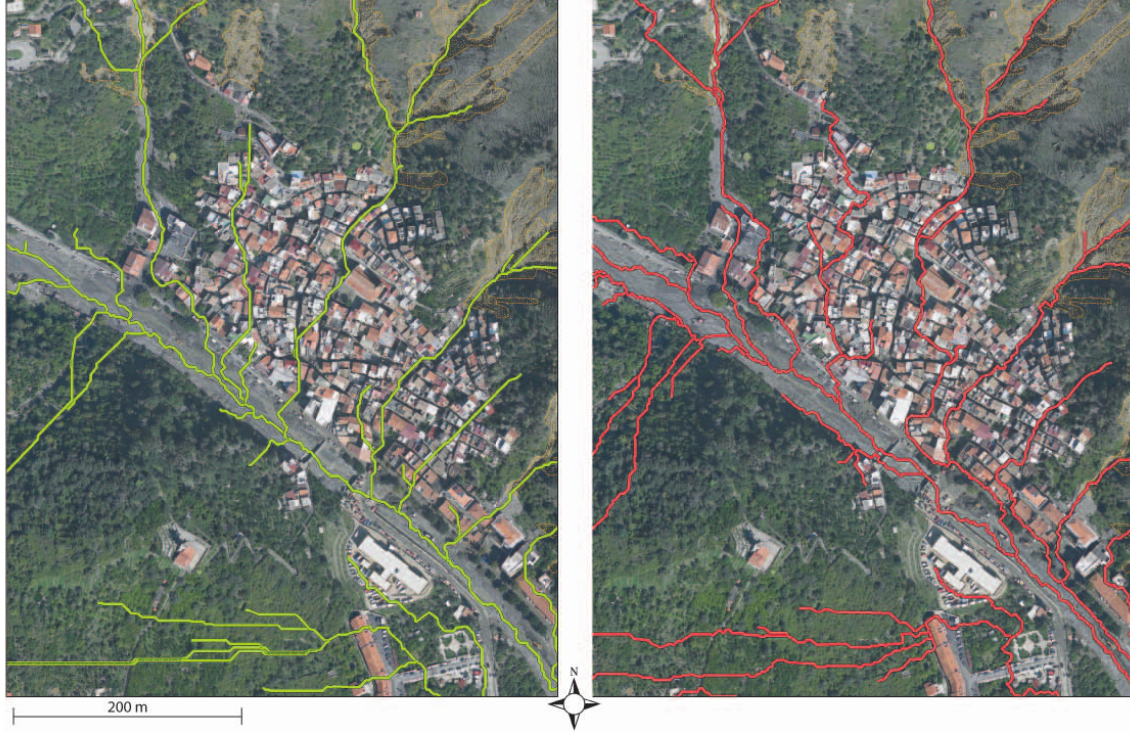
Fig. 10. Flow direction model. The natural flow (green lines) was determined from pre-event DEM. The urbanised flow (red lines) was derived from the pre-event DEM, by adding buildings obtained from a technical map, to show how the anthropic influence affected the flow